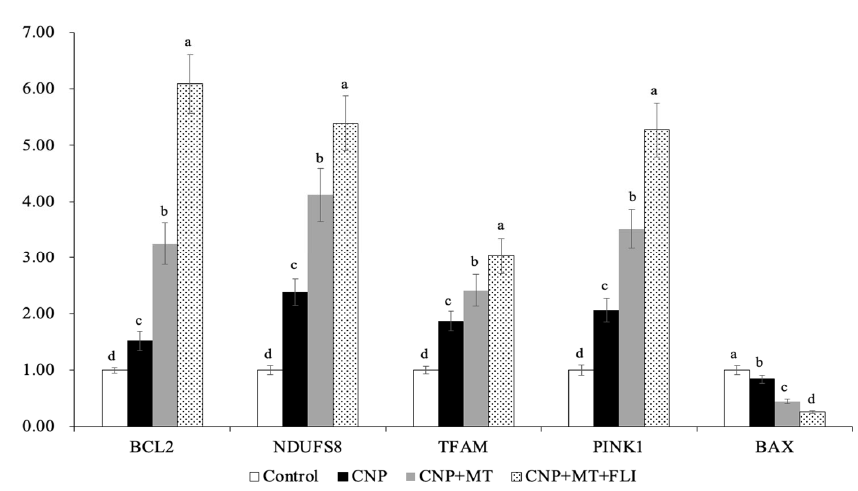
Figure 1. Effect of the combination treatment of CNP, MT, and FLI on the gene expression in blastocysts. a, b, c, d Values with different superscripts indicate significant differences between groups ( p < 0.05).